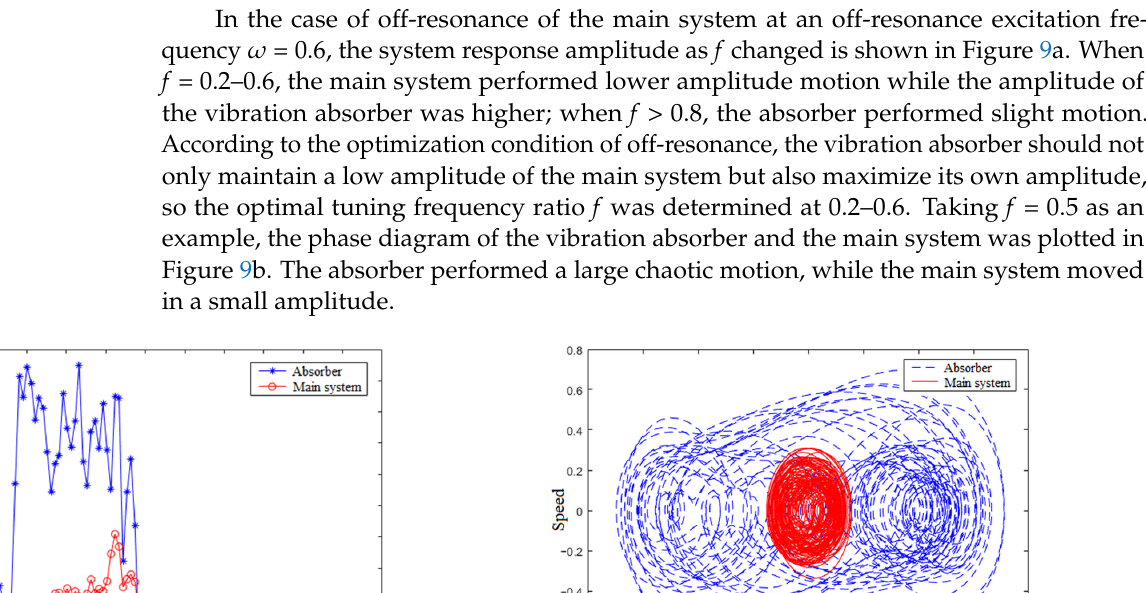
Figure 8. Response amplitude of two vibrators and phase diagram of the main system in the case of resonance ω = 1.0. ( a ) Response amplitude; ( b ) Phase diagram ( f = 1.7).